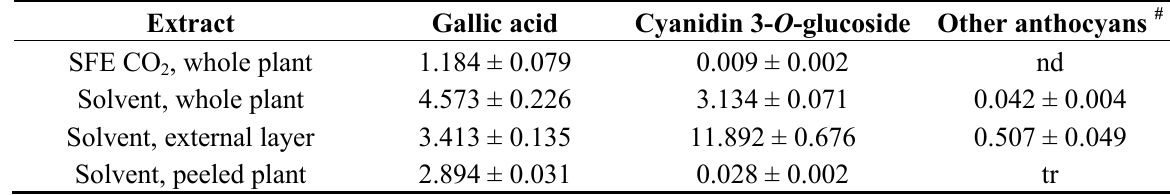
Table 2. Phenolic composition of C. coccineum extracts (mg/g